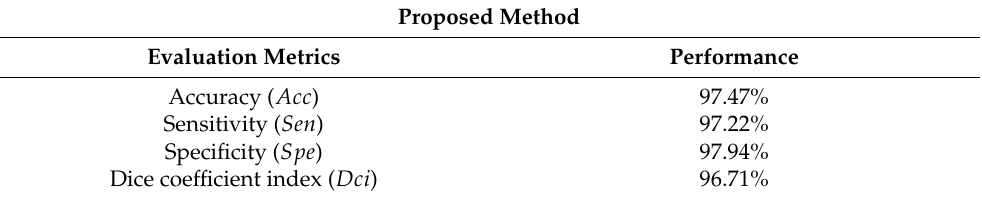
Table 3. Quantitative assessment of the proposed method using M-SVM classification.